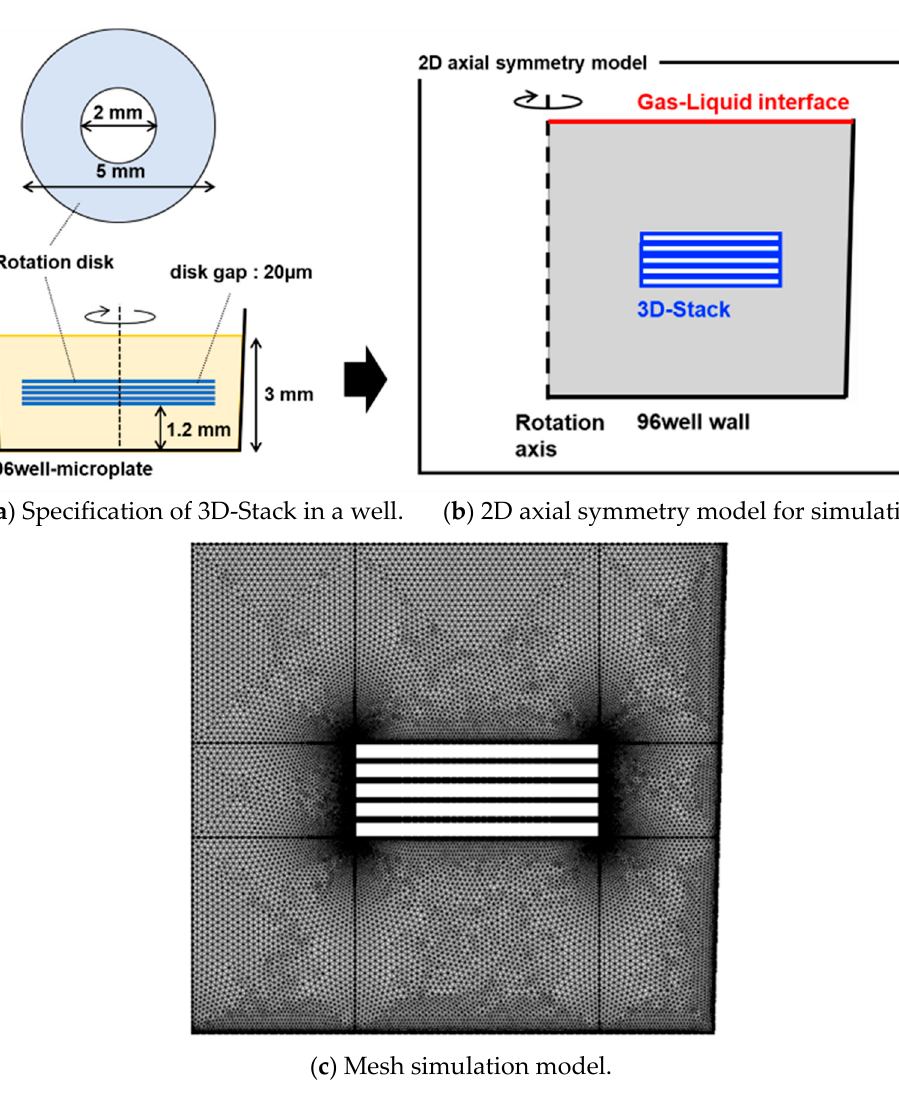
Figure 2. Specification of 3D-Stack in a well and the simulation model.